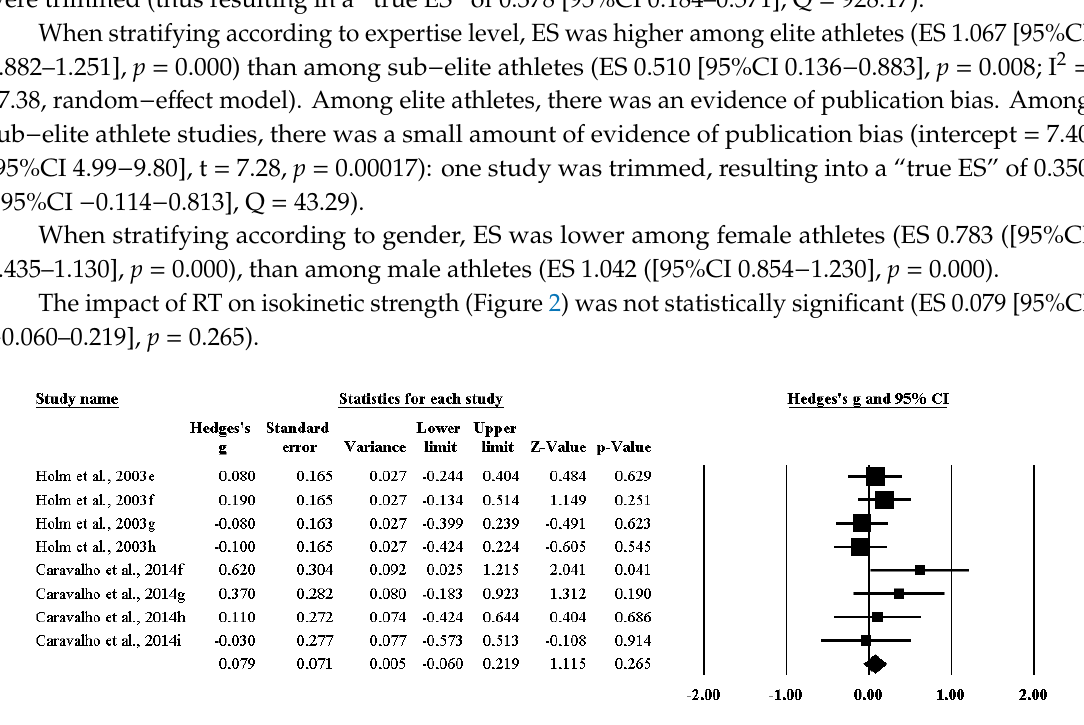
Figure 2. The impact of resistance training on isokinetic strength among handball players.